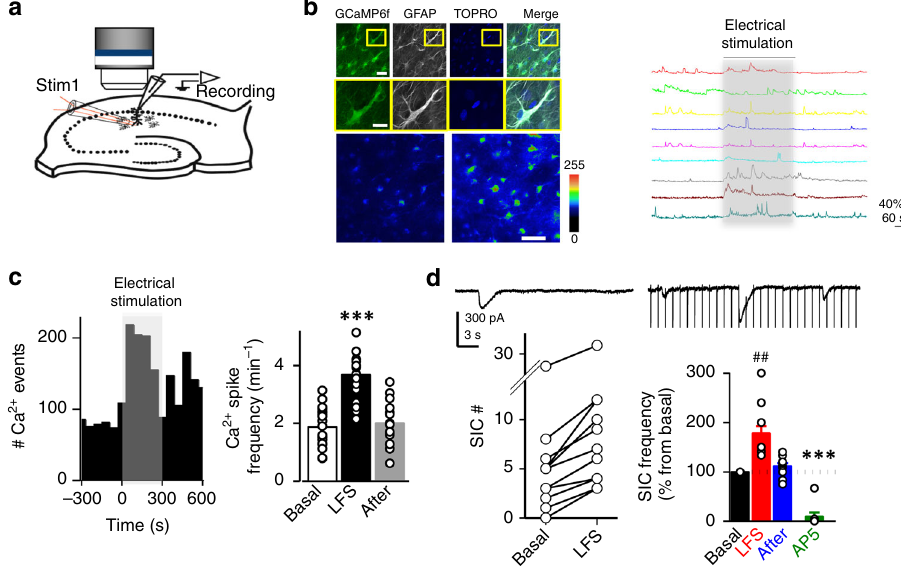
Fig. 1 Low-frequency stimulation (LFS) induces astrocyte – neuron communication. a Scheme showing the experimental con fi guration for electrical stimulation in stratum radiatum and whole-cell recording of CA1 pyramidal neurons. b Top, immunocytochemical localization of GCaMP6f (green), GFAP (gray), and TOPRO (blue) in acute hippocampal slices after in vivo injection with AAV5- P GFAP -cyto-GCaMP6f. Inset of high magni fi cation of representative astrocyte. Scale bars = 25 and 20 μ m, respectively. Representative pseudocolor images (bottom) and intensity Ca 2 + signals (right) versus time from nine astrocytes, obtained by live imaging from fl uorescence intensities of GCaMP6f in hippocampal acute slices before, during, and after LFS protocol (300 pulses at 1 Hz). Scale bar, 50 μ m. c Left, Representative experiment showing the number of calcium events during an LFS experiment in time bins of 50 s. Right, average spike frequency of Ca 2 + signals per slice before (baseline), during (LFS) and after LTD induction ( n = 20) P < 0.001 (***). Friedman test followed by Dunn's multiple comparison. d Top, representative whole-cell currents from a CA1 pyramidal neuron in an acute hippocampal slice, recorded before (left) and during (right) LFS. (Bottom, left) Number of SICs before and during LFS protocol from 12 different slices. (Bottom, right) summary bargraph of SIC frequency increases in response to LFS. Some slices were treated with the NMDAR antagonist AP5 (green n = 8). SICs were compared by Friedman test followed by Dunn's multiple comparison ( ## P < 0.01). AP5 vs. baseline were compared by Mann – Whitney test (*** P <